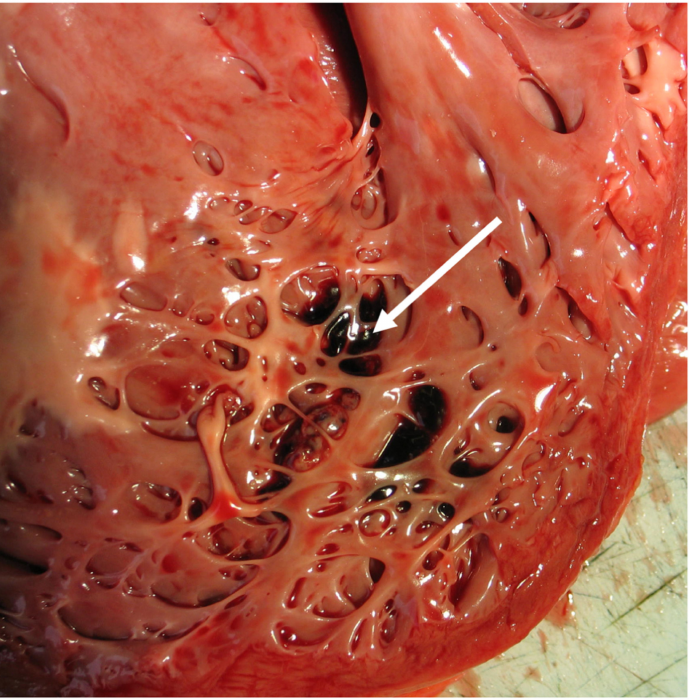
Figure 5. Autopsy specimen: left ventricle of a patient with NCCM and sudden cardiac death. A thin compacted layer and extensive trabeculation in the apical region. Small thrombi between the trabeculations